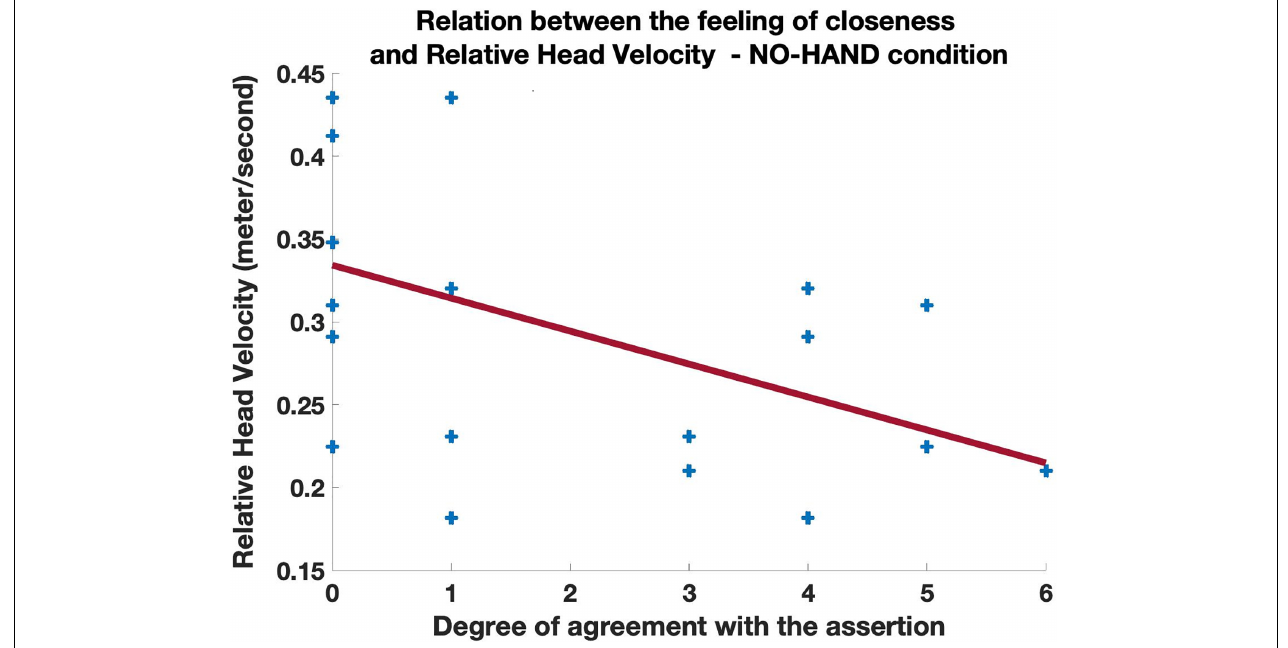
FIGURE 7 | Scatterplot of the relation between the responses to the question “ The absence of my own spheres made me feel more closeness with my partner ” and the Relative Head Velocity. 0 meant total disagreement and 6 total agreement with the assertion, with values in between corresponding to more moderate